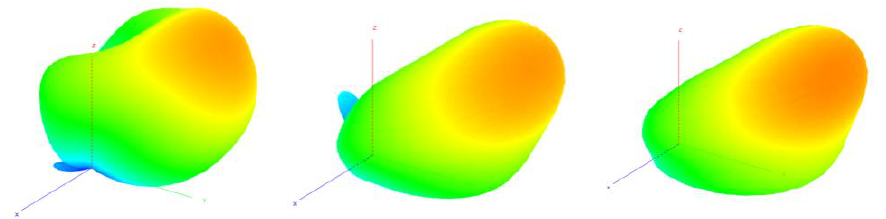
Figure 4. Measured 3D radiation patterns for each considered configuration with different inclination angles: θ max _ up , θ max _ mid , θ max _ down (from left to right).